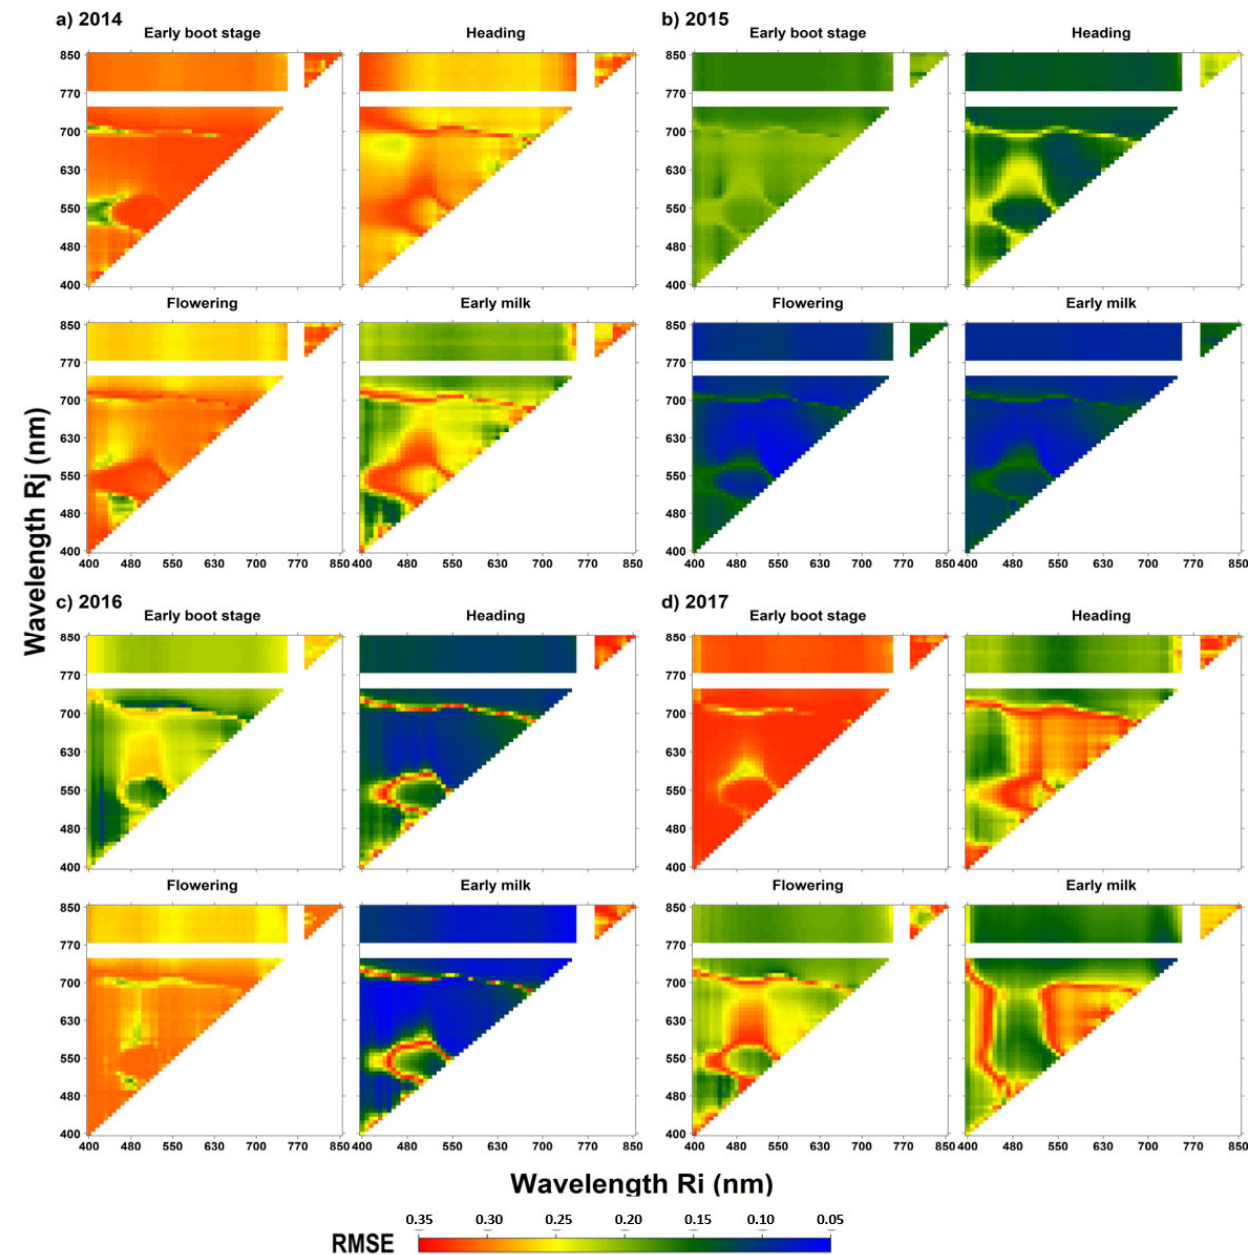
Figure 7. Contour maps of the root mean square error (RMSE, %N) between the NDSI ( Ri , Rj ) and grain N concentration using the complete combinations of two wavelengths at i and j within the range 400–850 nm, at different growth stages for different